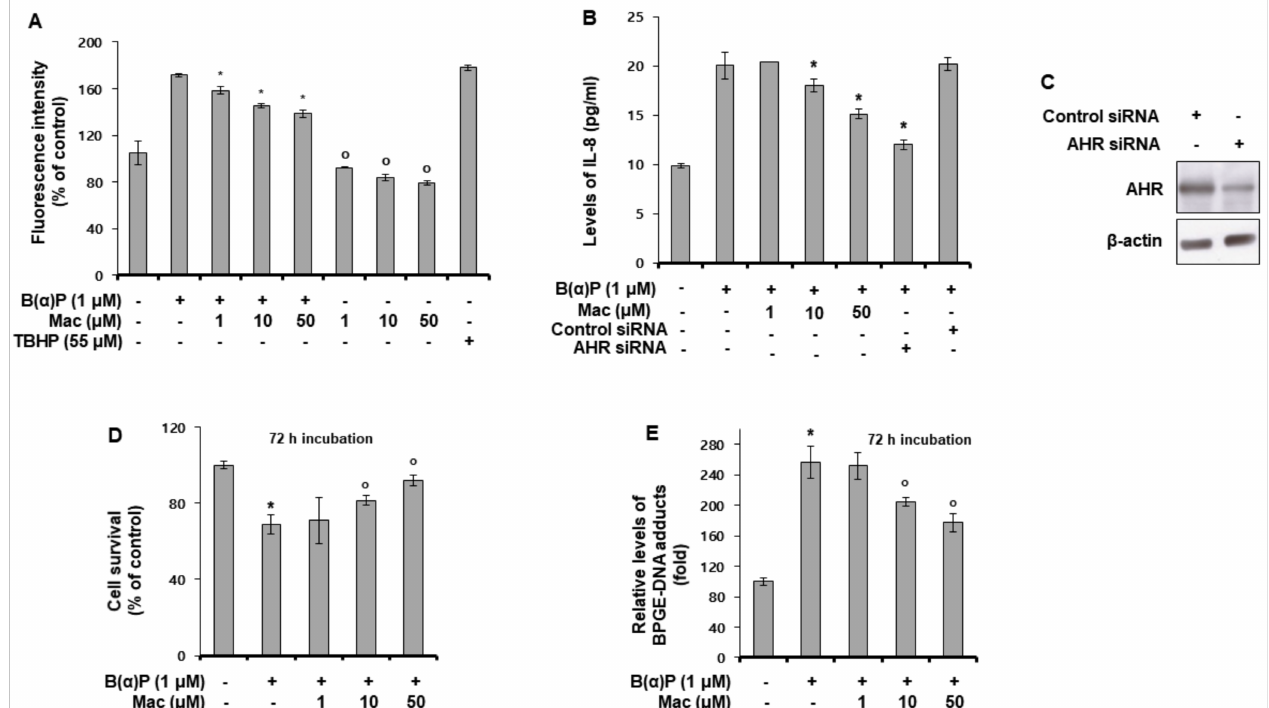
Figure 2. Maclurin attenuated intracellular production of ROS and IL-8, and reduced cell survival and BPDE-DNA adduct formation induced by B(a)P in HaCaT cells. ( A ) HaCaT cells were cultured with B(a)P and maclurin for 24 h, and the fluorescence intensity was analyzed. The data were verified by repeating independent experiment three times and the values represent the mean ± SD. * p < 0.05 vs. B(a)P treatment group, o p < 0.05 vs. untreated control. ( B , C ) HaCaT cells were transfected with AHR siRNA using the DharmaFECT ® Duo transfection reagent. After 24 h incubation, the cells were incubated with maclurin (1, 10, 50 µ M) and B(a)P (1 µ M) for 24 h and then analyzed by ELISA for IL-8 ( B ) and Western blotting for AHR ( C ). All results were confirmed from at least three independent experiments and the values represent the mean ± SD. * p < 0.05 vs. B(a)P treatment group. ( D , E ) HaCaT cells were treated with maclurin (1, 10, 50 µ M) and B(a)P (1 µ M) for 72 h, and the cell survival assay ( D ) and BPDE-DNA adduct formation analysis ( E ) were performed. The data are expressed as the mean ± S.D. * p < 0.05 vs. untreated control, o p < 0.05 vs. B(a)P-treated control. The data were confirmed from at least three independent experiments. TBHP: Tert-butyl hydroperoxide, Mac: